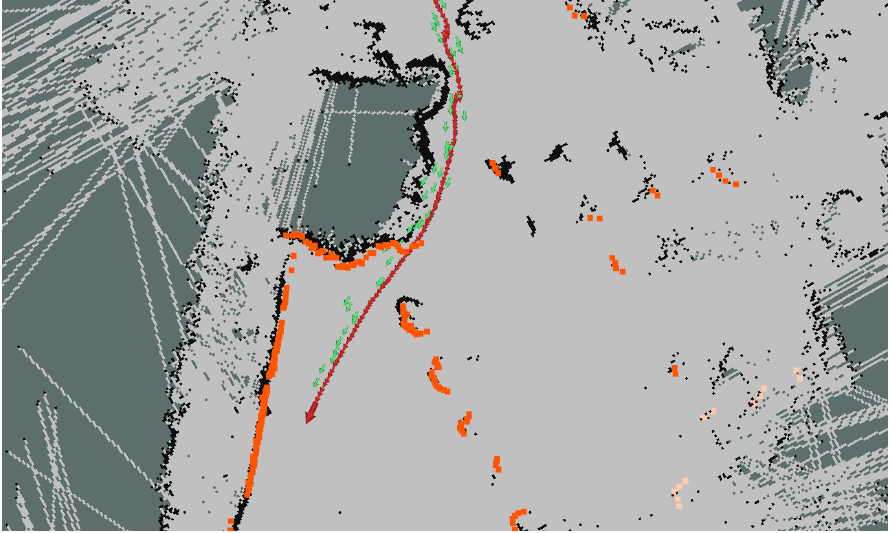
Figure 9. Example of localization using GNSS and LiDAR data.